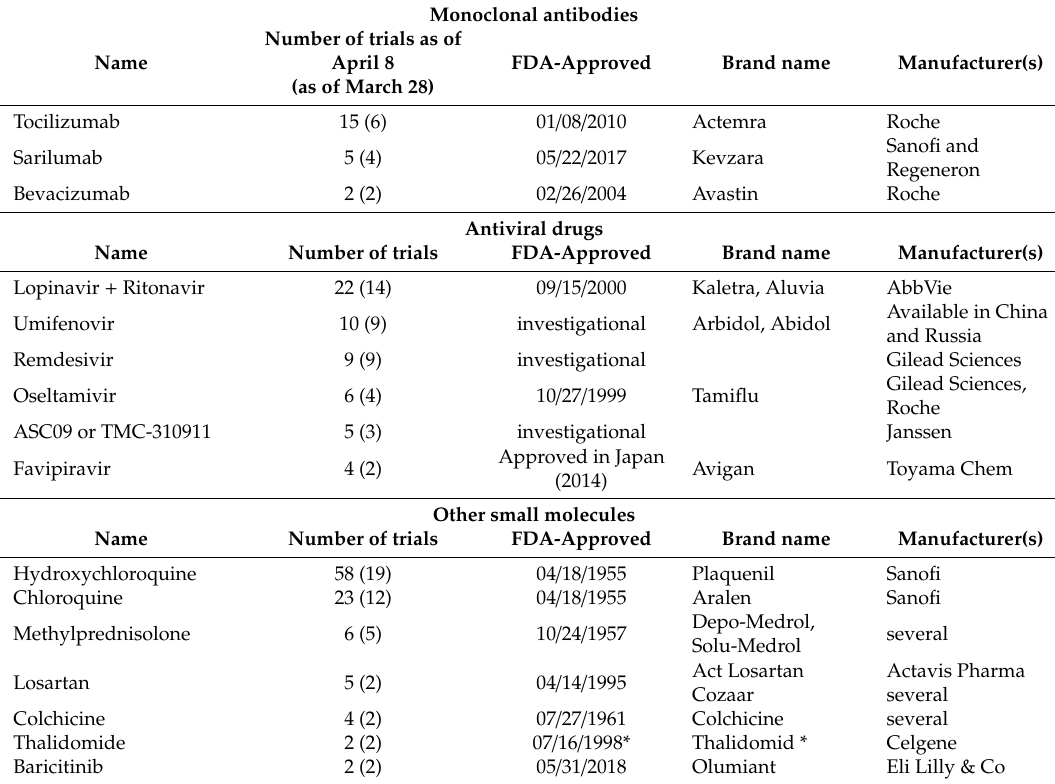
Table 1. Most cited monoclonal antibodies, antiviral drugs, and other small molecules in COVID-19 clinical